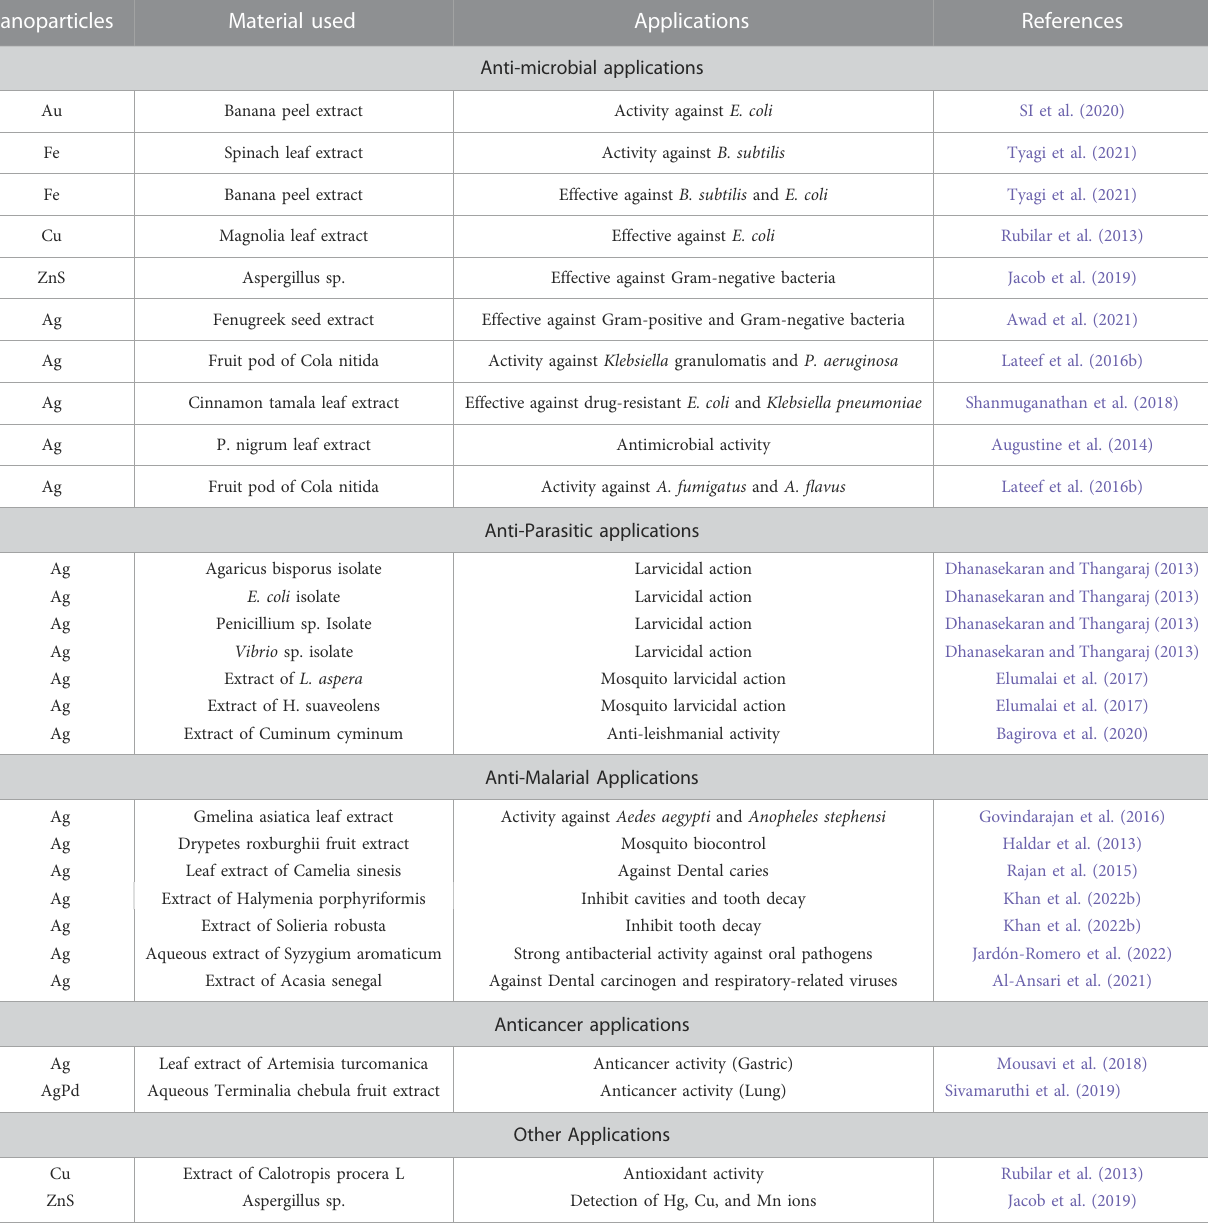
TABLE 3 Applications of Biogenic Nanoparticles in biomedical science.